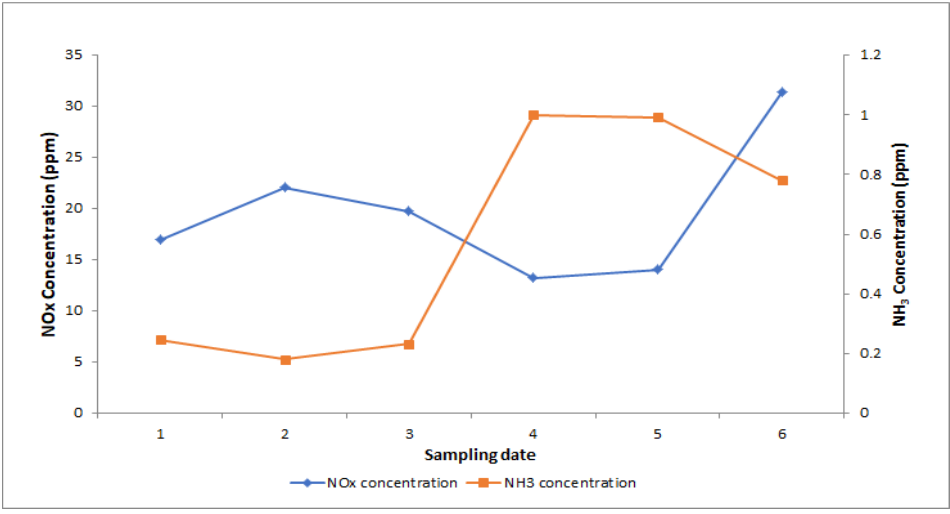
Figure 3. Correlation of NH 3 concentration and NOx concentration.